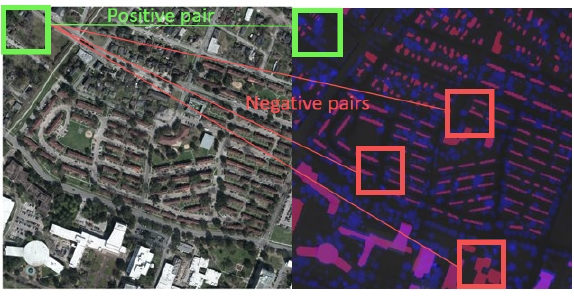
Figure 1. Positive and negative pairs on RGB & DEM imagery.